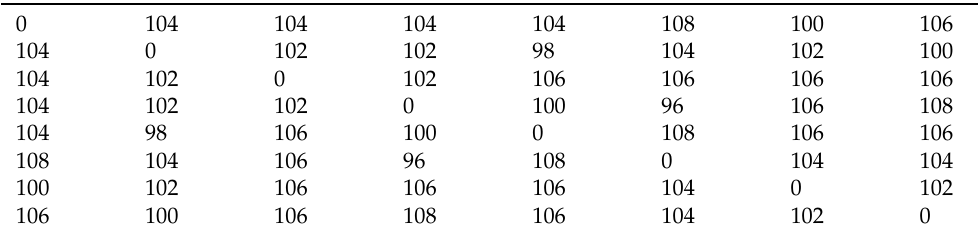
Table 7. Bit-independent criterion.